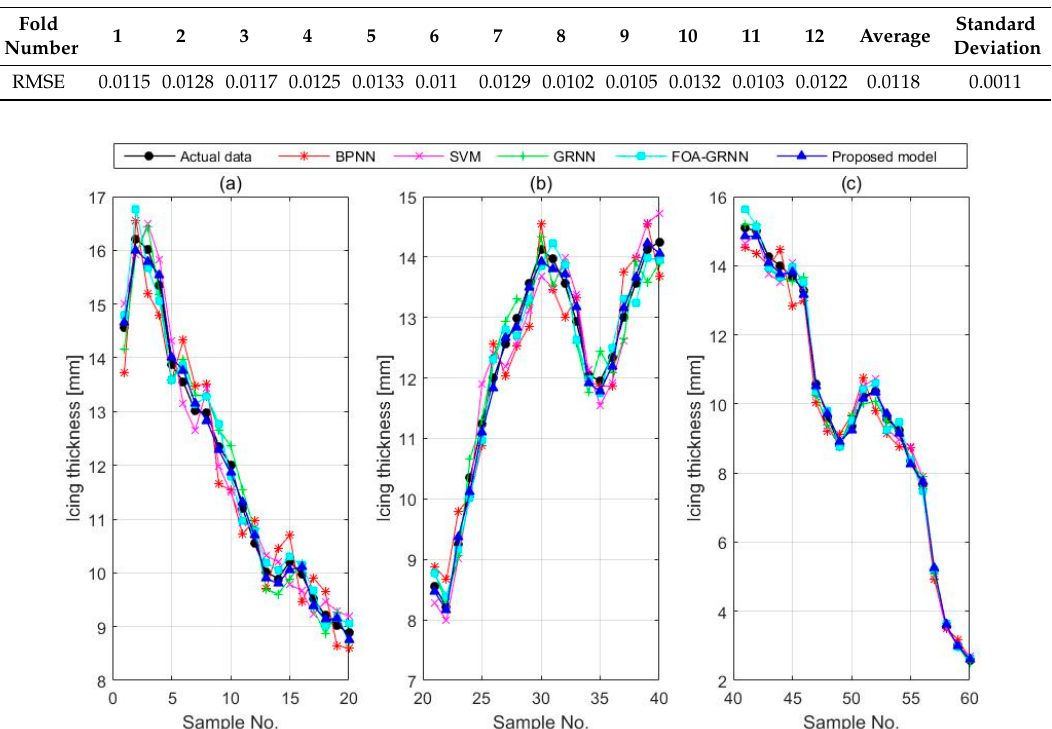
Figure 11. The forecasting values of the proposed method and the comparison methods. Note: ( a ) the forecasting value from sample points 1–20; ( b ) the forecasting value from sample points 21–40; and ( c ) the forecasting value from sample points 41–60.